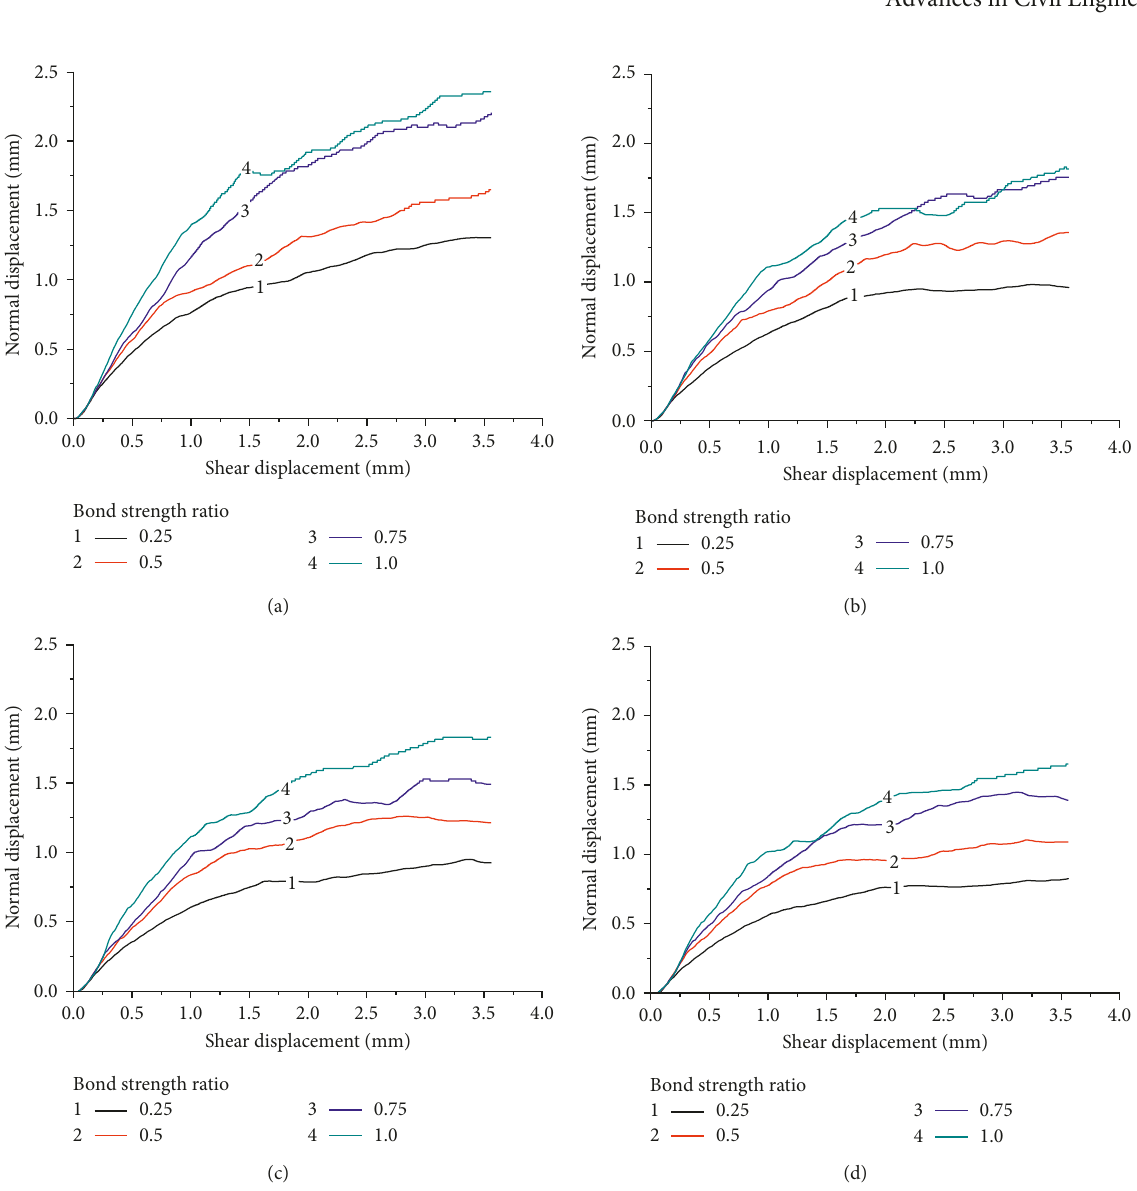
Figure 6: Dilation curve for specimen with different bond strength ratios: normal stress of (a)1.0MPa, (b) 2.0MPa, (c) 3.0MPa, and (d)